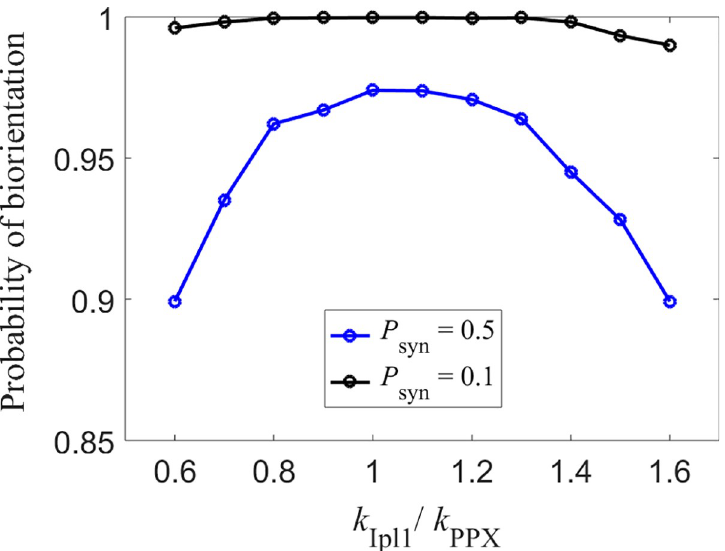
Fig 9. Effect of geometrical orientation of KTs on biorientation probability. Probability of biorientation within 10 min for different values of P syn . KTs start in unattached state. P syn = 0.5 corresponds to the case in which KTs in monotelic state transition to syntelic and amphitelic states with equal probability. The lowest error rate in this case is 4.5 × 10 − 2 per chromosome (occurs at k Ipl1 / k PPX = 1). P syn = 0.1 corresponds to the case in which KTs in monotelic state transition to amphitelic state 10 times more often than syntelic state. The error rate in this case at k Ipl1 / k PPX = 1 is 10 − 4 per chromosome.